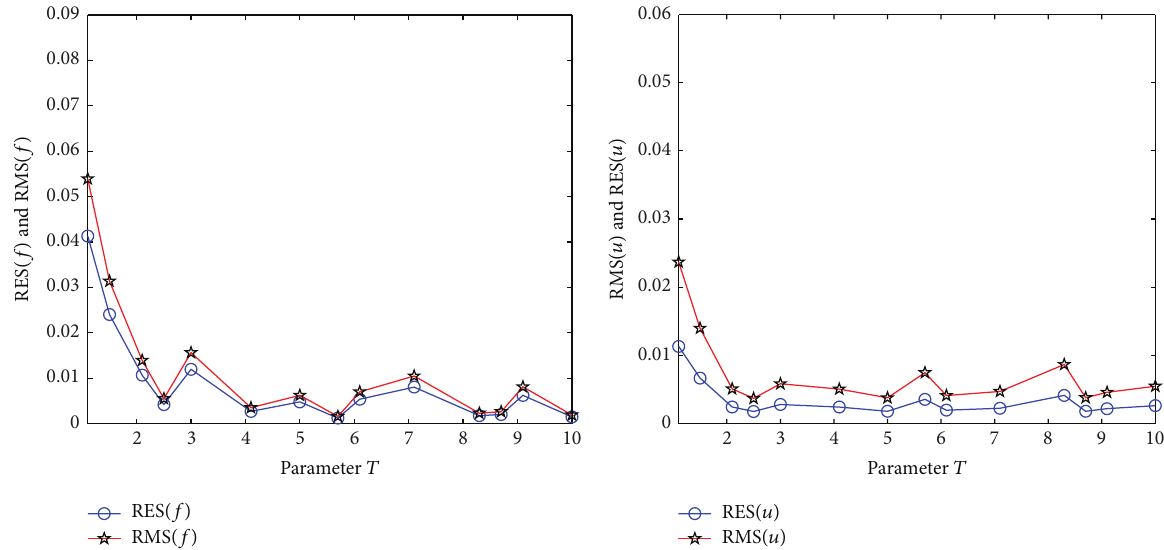
Figure 4: The accuracy of the obtained numerical results by MFSRBF for 𝛿 = 0.01 and 𝑥 0 = 0.5 versus the parameter 𝑇